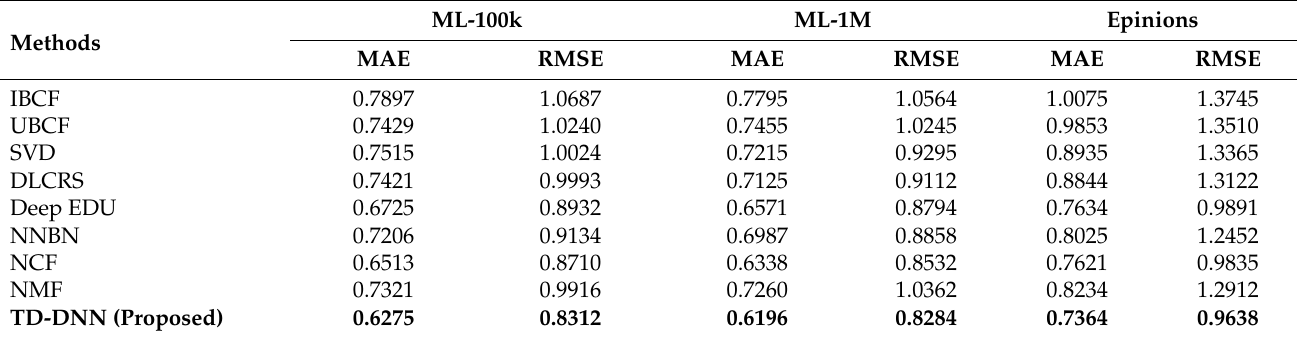
Table 12. MAE and RMSE values of various